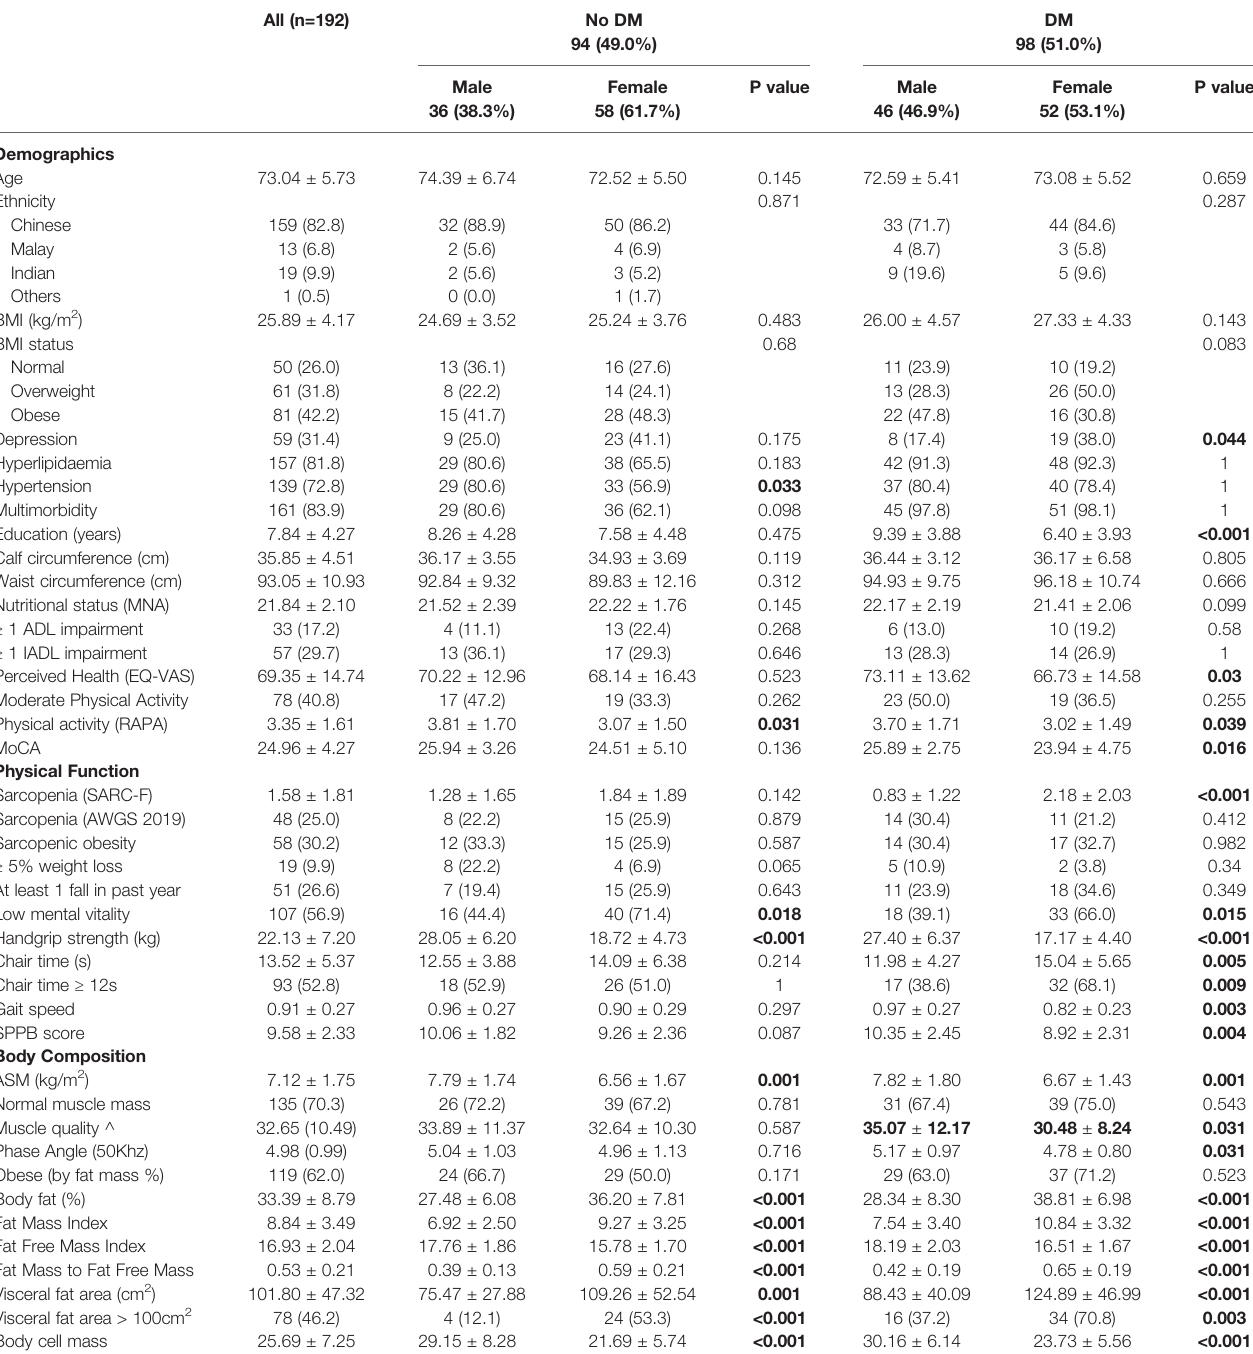
TABLE 2 | Characteristics table displaying between gender differences by Diabetes Mellitus (DM) Status. All